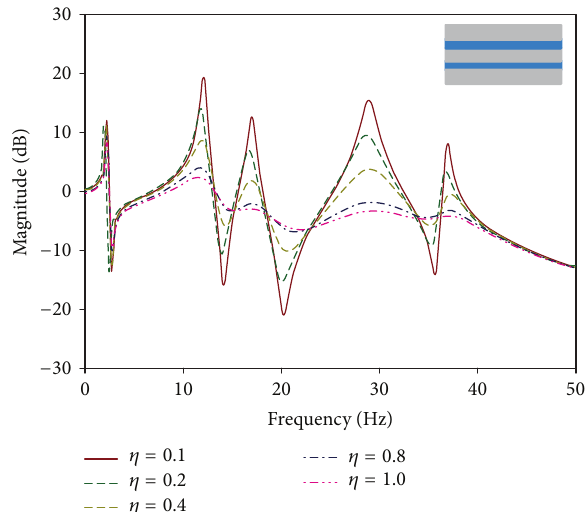
Figure 12: Frequency response of cylindrical aluminum panel in case of SDDL with variety of damping factors 𝜂 of viscoelastic material ( 𝑎 = 0.2 m, 𝜙 = 0.01 rad, 𝑅 = 20 m, 𝑡 4 = 3 mm, 𝑡 5 = 1 mm, = 4 mm, 𝑡 = 1 mm, and 𝑡 = 3 mm). 𝑡 6 7 8